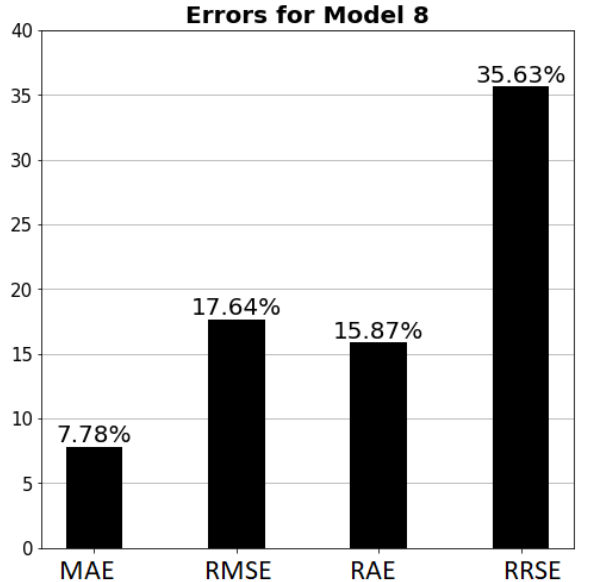
Figure 10. Associated errors on the fog node (using a model with KNN, NB, and DT as the base classifiers as well as voting as an ensemble method). Here, MAE stands for mean absolute Eeror, RMSE stands for root mean square error, RAE stands for root absolute error, and RRSE stands for root-relative squared error.